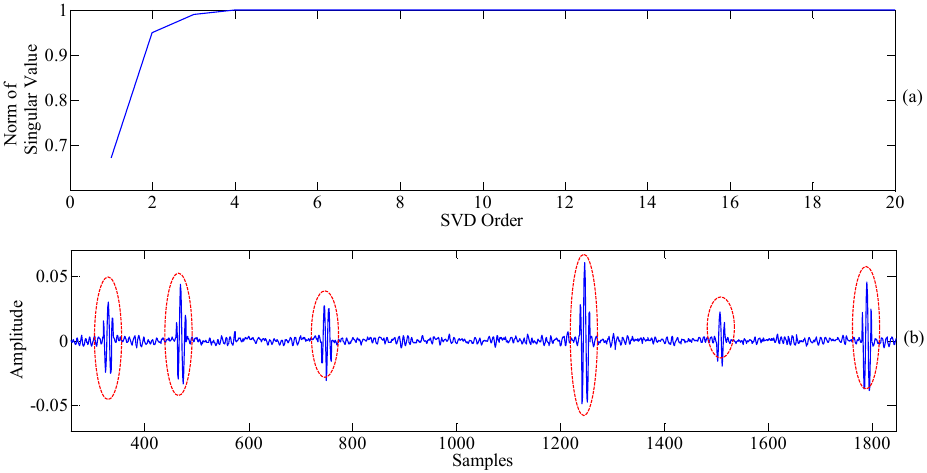
Figure 7. Detection of catastrophe points in signal described by Equation (20). ( a ) Norm of singular value; ( b ) The waveform of P 5 . Table 3. Parameter identification of Equation (20).